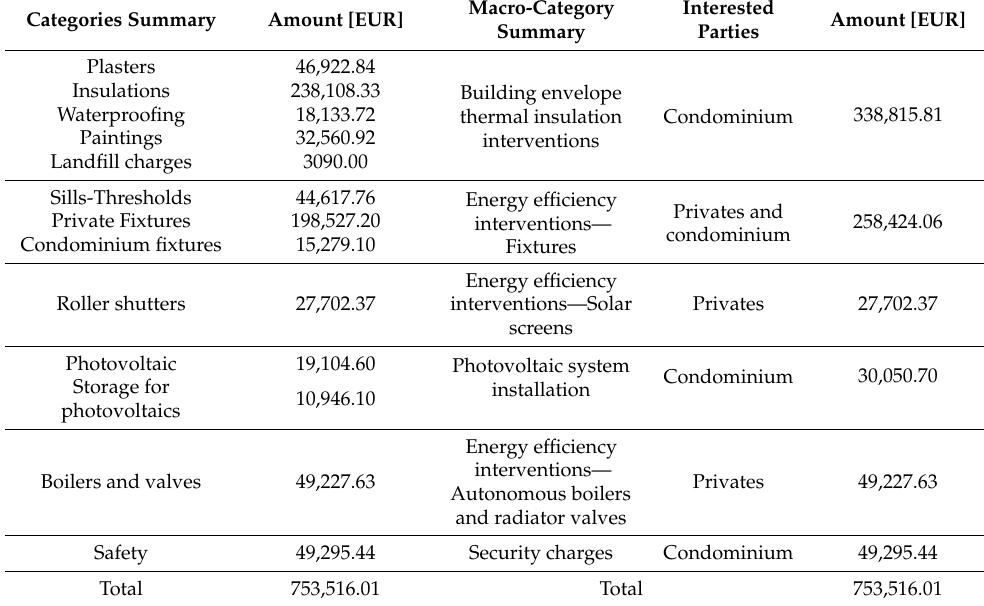
Table 2. Works categories and macro-categories.